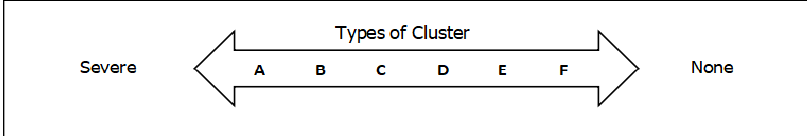
Figure 3. Comparison of severity levels between clusters.